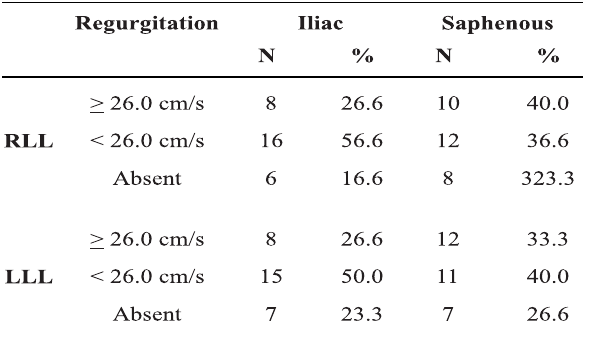
Table 3. Correlation between iliac and great saphenous ostial valvular regurgitation.